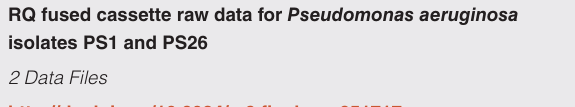
Figshare: Polycistronic transcription of fused cassettes and identi- fication of translation initiation signals in an unusual gene cassette array from Pseudomonas aeruginosa doi: http://dx.doi.org/10.6084/ m9.figshare.651717 19